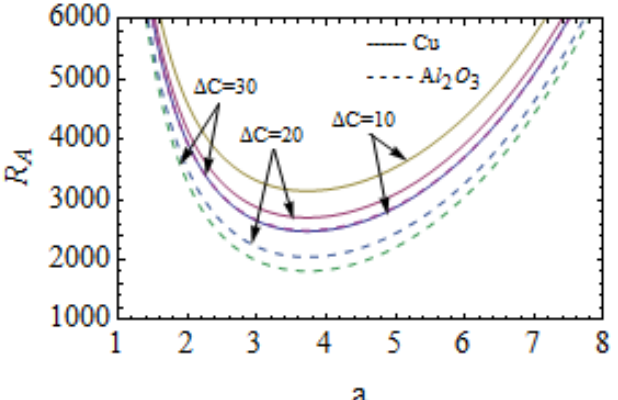
Figure 2. Impact of solute concentration difference